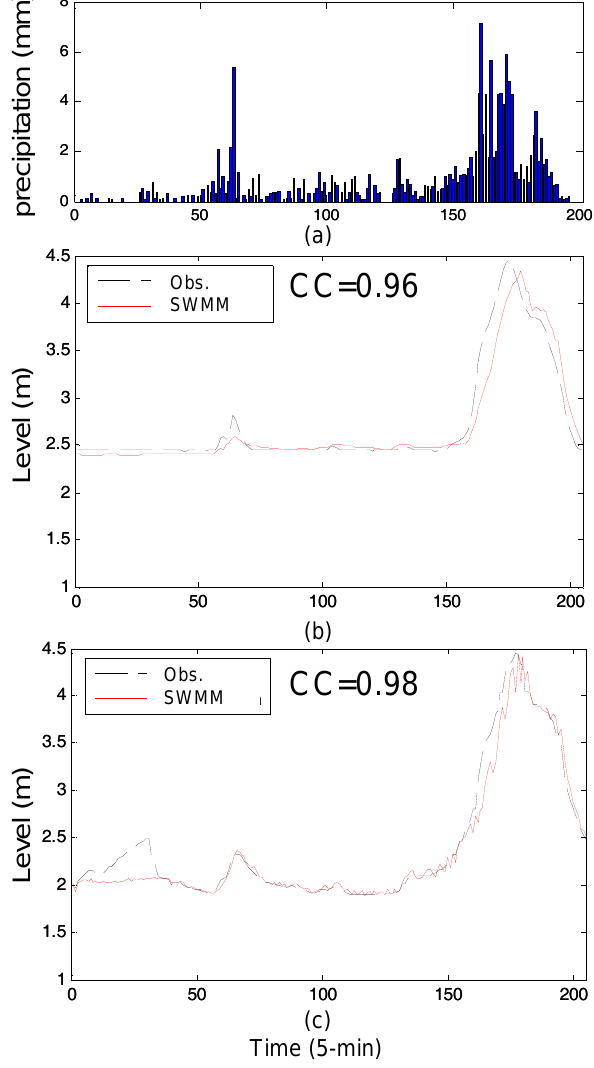
Fig. 4. (a) The rainfall hyetograph, (b) the SWMM hydrograph at Station YC4, (c) the SWMM hydrograph at Station YC8. Figure 4 (a) The rainfall hyetograph, (b) the SWMM hydrograph at Station YC4, (c) 651 the SWMM hydrograph at Station YC8 652 by the SWMM corresponding to Station YC4 and Station YC8 were evaluated. Figure 4a showed the rainfall hyeto- graph of an event randomly selected from datasets, whereas Fig. 4b and c showed the hydrographs of the SWMM out- put values versus the observation values at Stations YC4 and YC8, accordingly. It clearly indicated that the water levels estimated by the SWMM well captured the main trends of observations at both stations. The accuracies of the simulated flows at Stations YC4 and YC8 were 0.96 and 0.98 each in terms of the correlation coefficient (CC). Results displayed in Fig. 4 confirmed a high reliability of the SWMM simula- tions. Frankly speaking, the calibration procedure of SWMM is complex, for example, the optimization of parameters